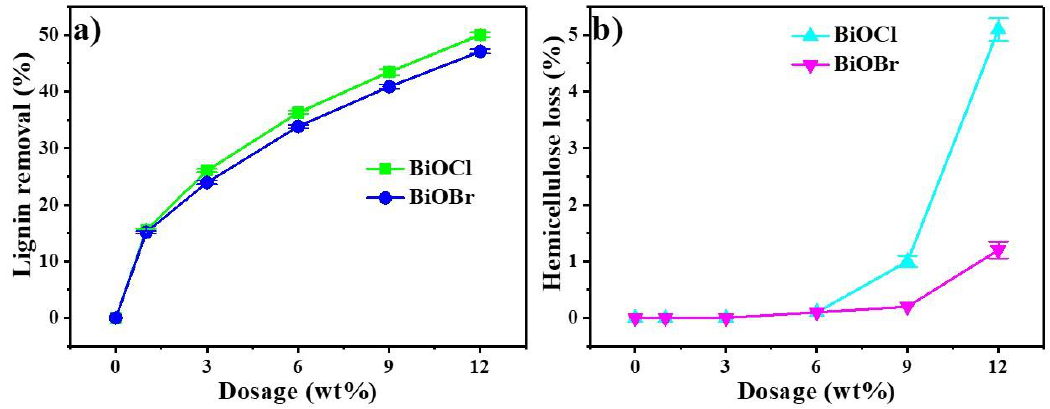
Figure 3. Effect of BiOCl/BiOBr dosage on the lignin removal ( a ) and HDS loss ( b ) of PHL.